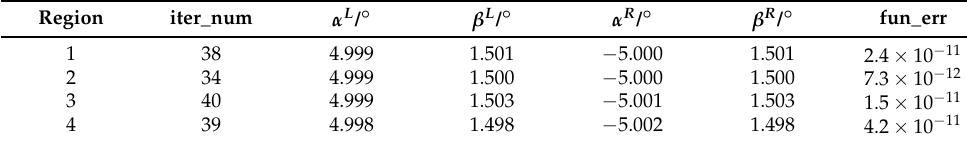
Figure 6. Distribution of gaze points. Table 3. Kappa-angle calibration results with different gaze